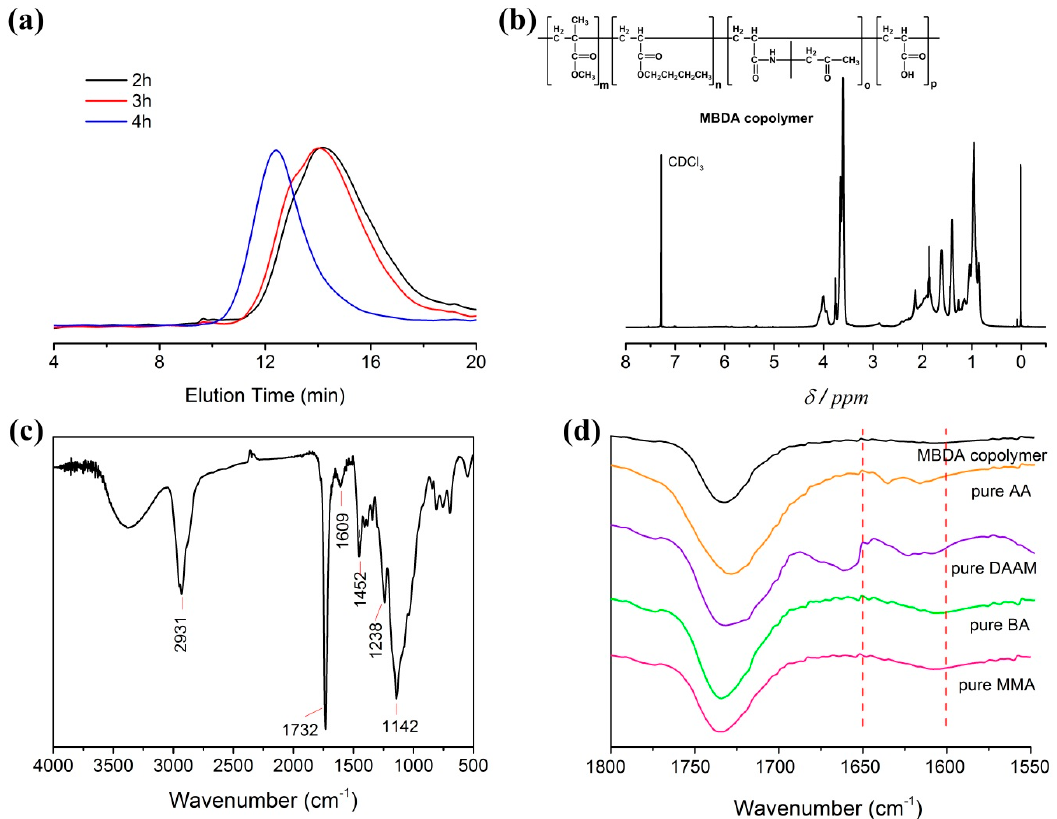
Figure 1. ( a ) GPC ( Gel Permeation Chromatography) trace of MBDA copolymer; ( b ) 1 H NMR (Hydrogen Nuclear Magnetic Resonance) spectrum of MBDA copolymer in CDCl 3 ; ( c ) FT-IR (Fourier transform-infrared) spectrum of MBDA copolymer; ( d ) FT-IR spectra of pure monomers with confined wavenumbers ranging from 1800 to 1550 cm − 1 (focused on the unsaturated “C=C”). Table 2. Chemical shifts of 1 H NMR spectral lines observed for MBDA copolymer. Polymer Structure Resonance